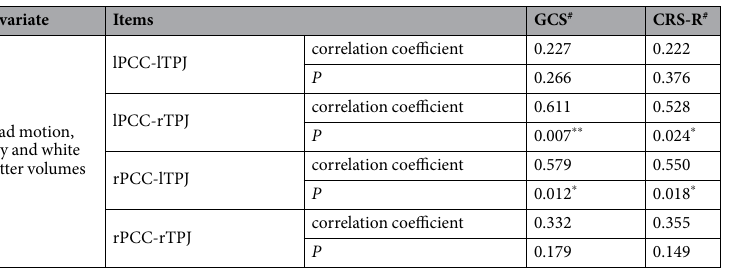
Table 4. Partial Correlation Analysis of the Intra- and Cross-hemispheric Functional Connectivity Strengths with both the GCS and CRS-R Scores. This table shows the partial correlation statistical data between the PCC- TPJ FCSs and the consciousness assessments (GCS and CRS-R) with covariates of head motion (Mt) and grey and white matter volumes. P.S.: GCS # : Glasgow Coma Scale assessment. CRS-R # : CRS-Revised assessment. ** α = 0.01; * α =